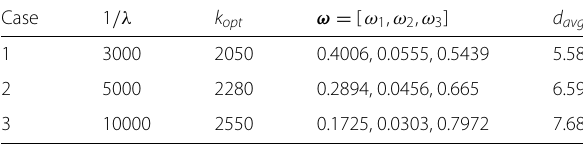
Table 1 Optimal code length k opt and weighting vector ω